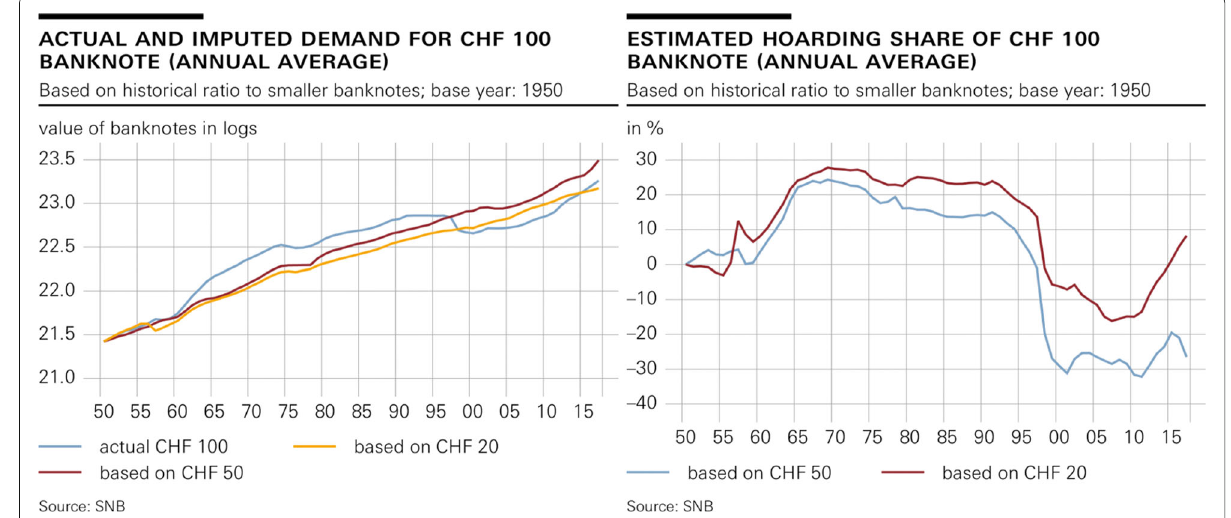
Fig. 4 Method based on ratios - results for CHF 100 banknote